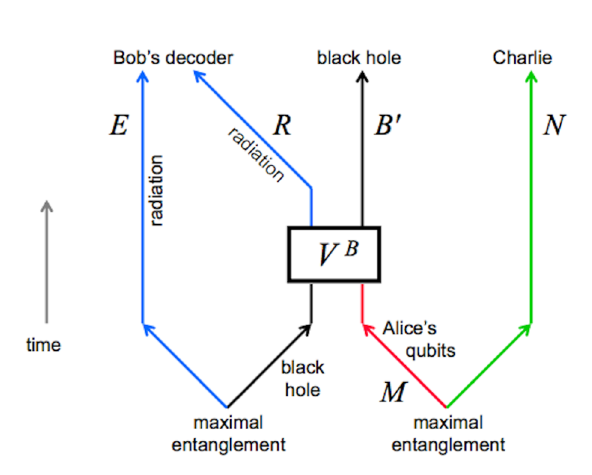
Figure 4 . Quantum circuit corresponding to the Hayden-Preskill protocol. Figure from